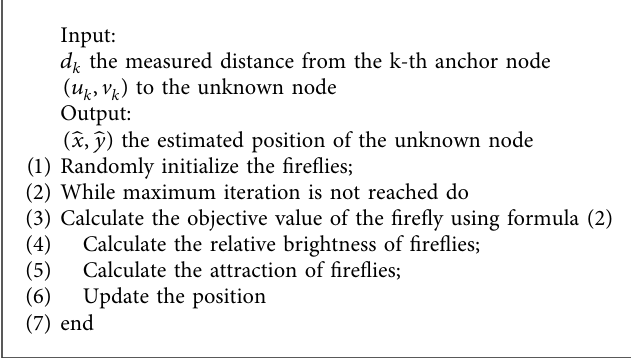
A LGORITHM 1: Traditional firefly algorithm. Specific flow of the traditional firefly